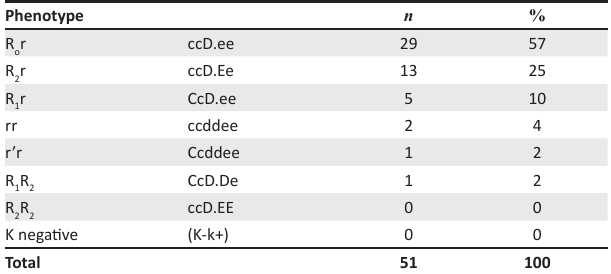
TABLE 4: Rhesus and Kell phenotypes amongst 51 healthy Kenyan blood donors at Kenyatta National Hospital, 2014.